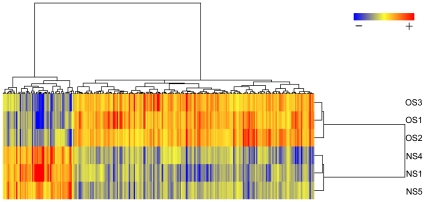
Hierarchical clustering of significantly differentially regulated genes in conch testis.Red color represents expression of a gene at a level greater than the row (gene) average, and blue color represents expression lower than the row average. The map shows a clear distinction between nearshore (NS) and offshore (OS) testis samples based on the 256 differentially-regulated transcripts. Approximately one-fourth of the regulated transcripts are up-regulated in NS relative to OS; the majority are down-regulated.